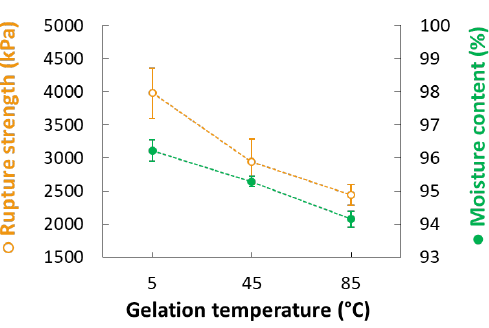
Figure 6. Rupture strength (open circles) and moisture content (filled circles) of CAG beads prepared at different gelation temperatures.